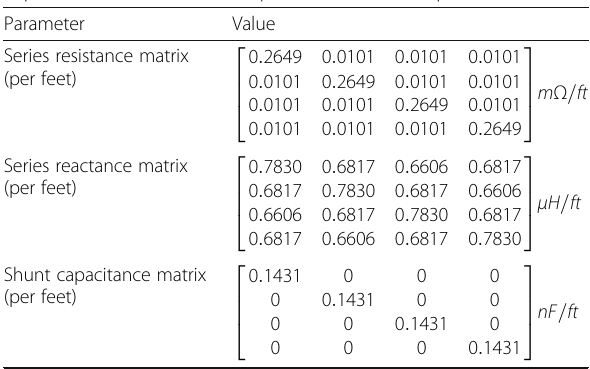
Table 2 Series resistance, series reactance and shunt capacitance matrices of the μ Grid circuit under protection